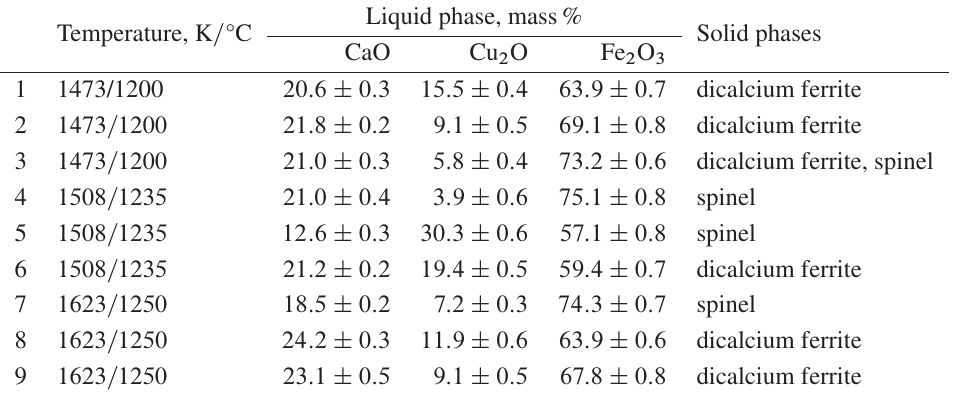
Table 2. Phase compositions in the Cu-Ca-Fe-O system, obtained by levitation technique.